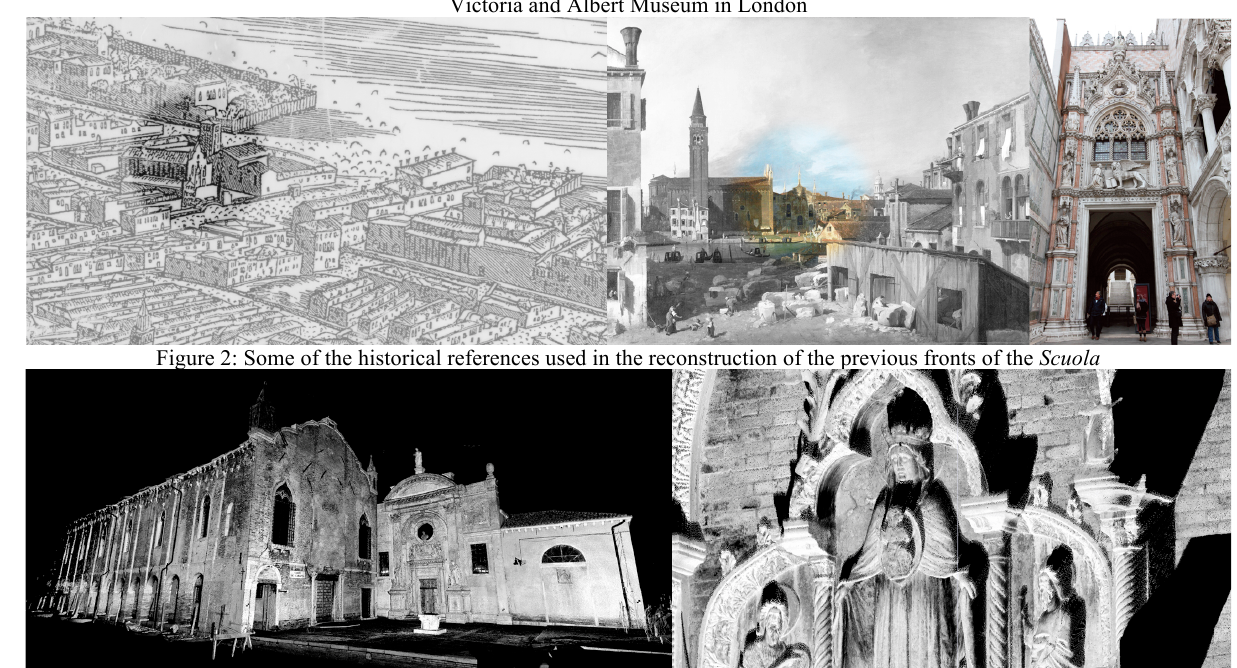
Figure 2: Some of the historical references used in the reconstruction of the previous fronts of the Scuola